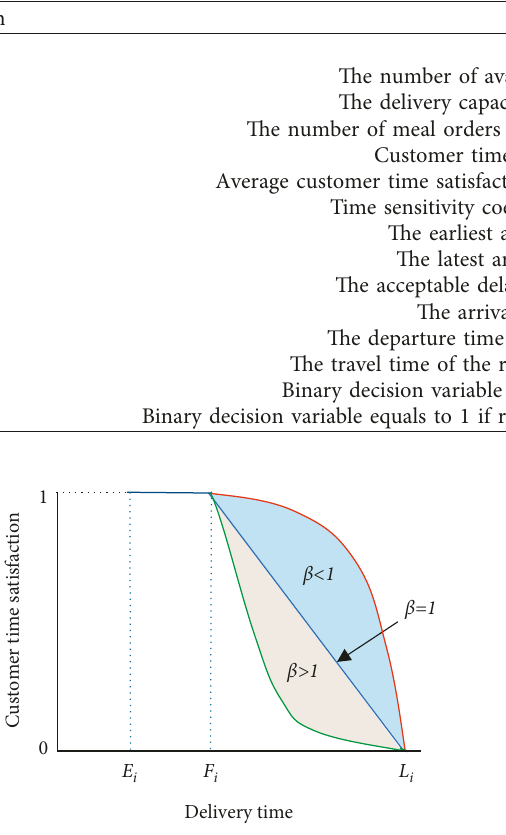
Figure 2: Customer time satisfaction function with different time sensitivity coefficients.